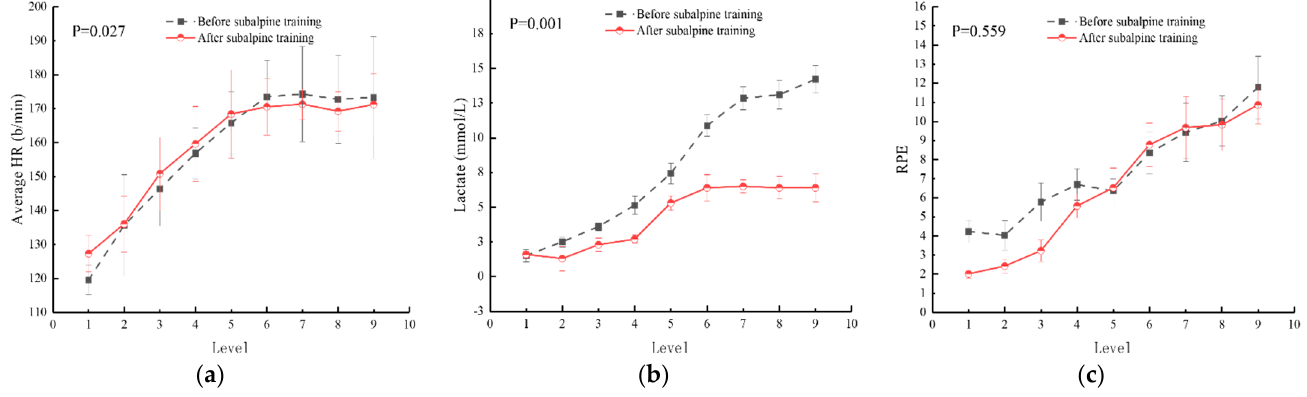
Figure 4. Male athletes’ ( a ) mean heart rate by level; ( b ) blood lactate concentration by level; ( c ) RPE by level. Data are mean ± SD.